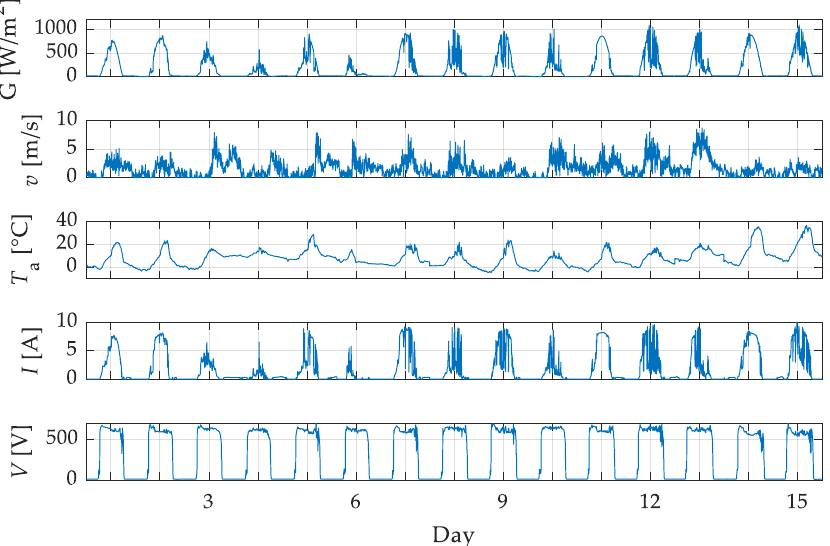
Figure 2. Meteorological and experimental data of the density of solar radiation G , wind speed v , ambient temperature T a , current I DC and voltage V DC .